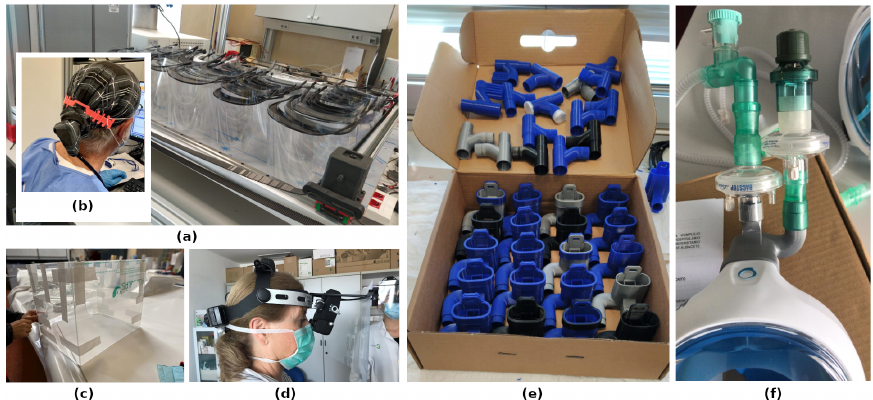
Figure 6. Some products manufactured by UCLM in the solidarity project. ( a ) Face shields, ( b ) ear-savers, ( c ) personal protective equipment (PPE) box for the protection of healthcare professionals in the process of intubation, ( d ) customized face shield coupled to ophthalmoscopes, ( e ) detail of Charlotte valve coupled to air filters, and ( f ) Charlotte valves and Dave coupling for oxygenation systems based on Decathlon snorkel masks.